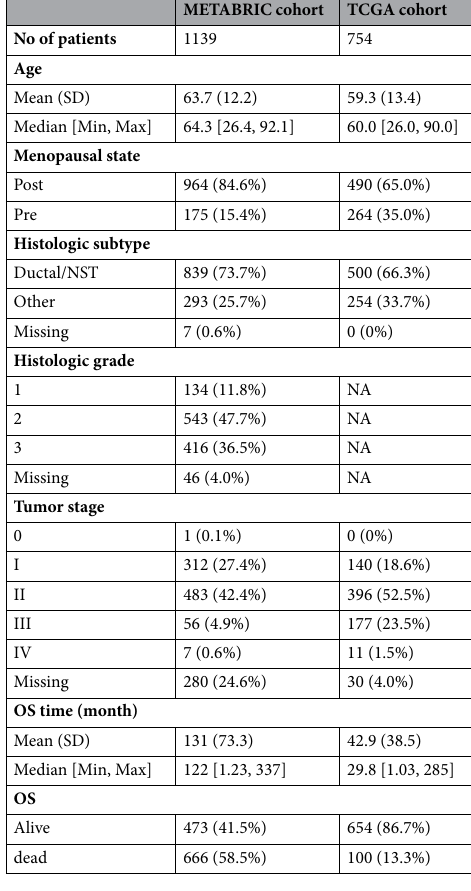
Table 1. Clinical characteristics of the BRCA patients used in this